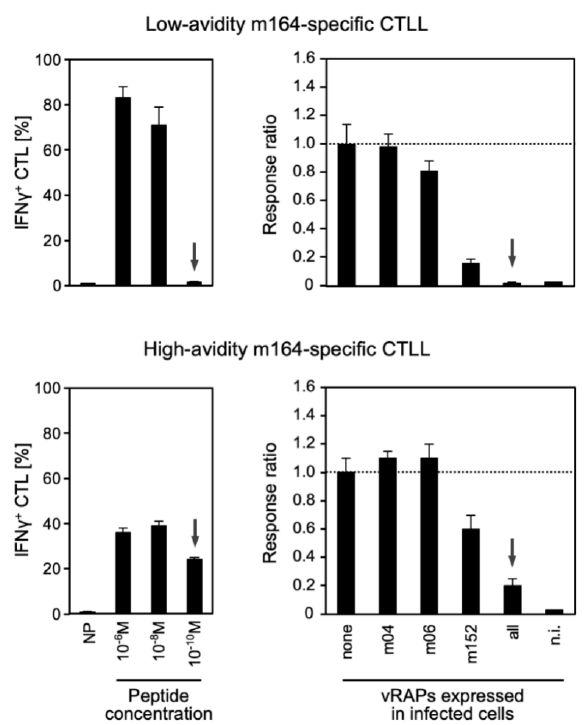
Figure 6. vRAP-modulated recognition of infected cells depending on CD8 T-cell functional avidity. CTLL differing in functional avidities for the D d -presented m164 epitope were generated by repetitive stimulation of mCMV-primed memory CD8 T cells with the corresponding synthetic antigenic peptide at concentrations of 10 − 8 M (positively selecting low avidity cells) and 10 − 10 M (positively selecting high avidity cells). (Left panels) Recognition of MEF target cells by the m164 epitope-specific low and high avidity CTLL cells after exogenous loading with synthetic m164 peptide at the indicated molar concentrations. NP, negative control with no peptide loading. Arrows point to the decisive message highlighting the difference between low and high avidity. Bars show the proportion of cells responding in the ELISpot assay by secretion of IFN- γ , error bars indicate the 95% confidence intervals. (Right panels) Corresponding recognition of MEF infected with a panel of recombinant mCMVs selectively expressing the indicated ‘viral regulators of antigen presentation’ (vRAP). None, no vRAP expressed after infection with the triple gene-deletion mutant mCMV- ∆ vRAP. All, vRAPs m04, m06, and m152 expressed after infection with the parental virus that corresponds to wild-type mCMV. n.i., uninfected MEF. Frequencies of responding cells were normalized to the response against MEF not expressing vRAPs after infection with the triple gene-deletion mutant. Bars represent response ratios, with ratio 1.0 defined by the most probable number determined for the triple gene-deletion mutant. Error bars represent the 95% confidence intervals. The arrows highlight the impact of functional avidity on the recognition of cells expressing all vRAPs.